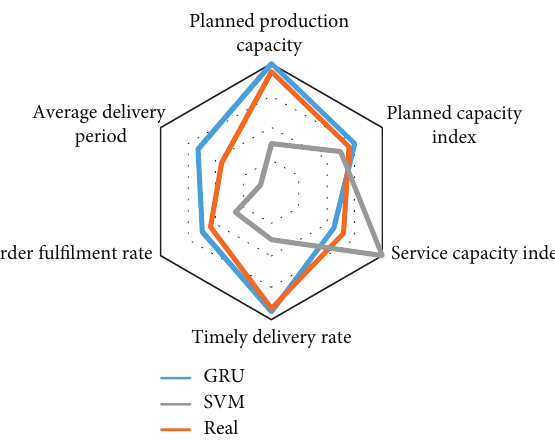
Figure 6: Simulation results compared with the SVM algorithm.